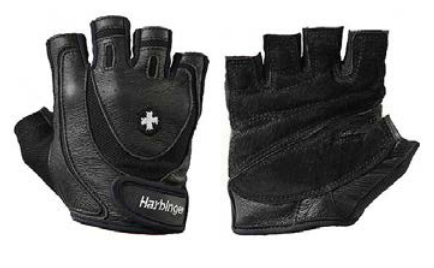
Fig. 2. Harbinger “Flex Fit” Workout Glove used in Mobile Music